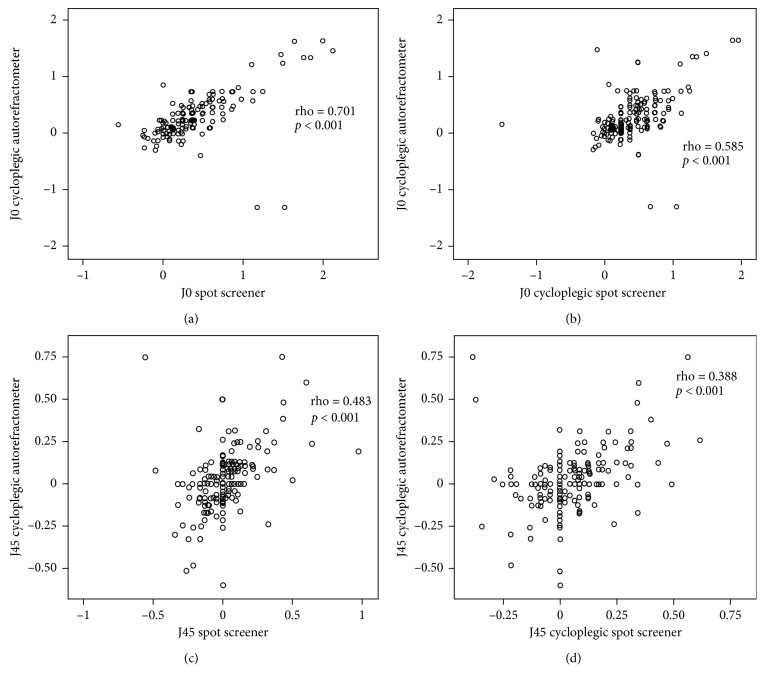
Correlations between J0 and J45 values of cycloplegic autorefractometer and Spot with or without cycloplegia.